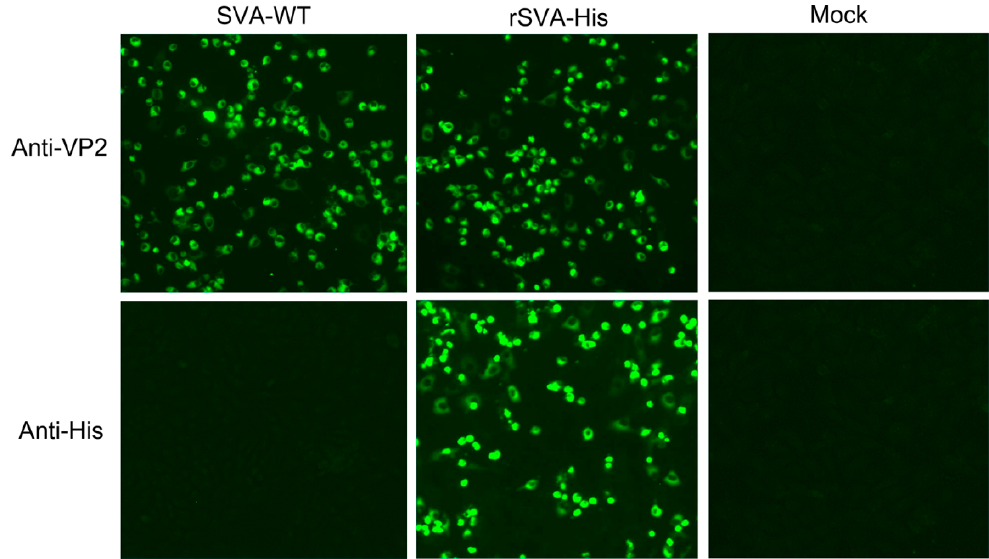
Figure 2. Detection of rSVA ‐ His on immunofluorescence. The BHK ‐ 21 cells infected with rSVA ‐ His were incubated with anti ‐ VP2 mAb or anti ‐ His mAb, and detected by the anti ‐ mouse FITC. The BHK ‐ 21 cells infected with SVA/HLJ/CHA/2016 were used as the positive controls and normal BHK ‐ 21 cells were used as the negative control.